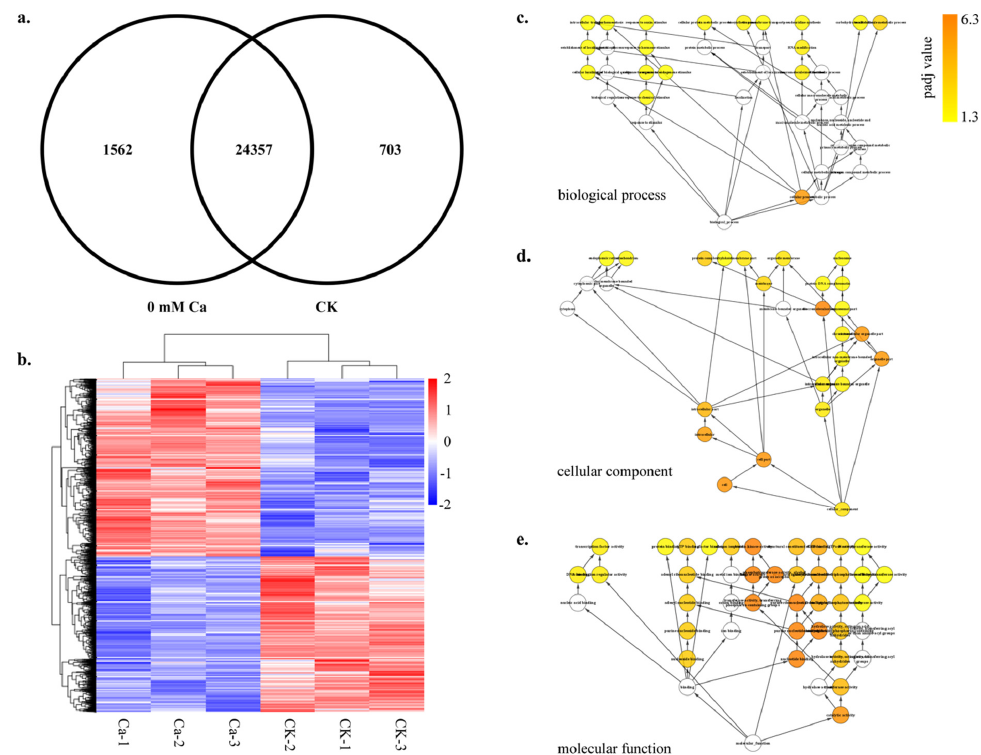
Figure 4. Preferential expression of genes during tipburn outbreak in Chinese cabbage. ( a ) Venn diagram of identified DEGs between samples in Chinese cabbage during calcium-deficiency-induced tipburn. ( b ) Heatmap showing the expression profile of preferentially expressed genes in CK and 0 mM Ca treatment samples. ( c – e ) Gene ontology (GO) enrichment of preferentially expressed genes in CK and 0 mM Ca treatment samples. Colors are shaded according to the significance level (white means no significant difference; color scale, yellow p -value = 0.05, orange p -value <